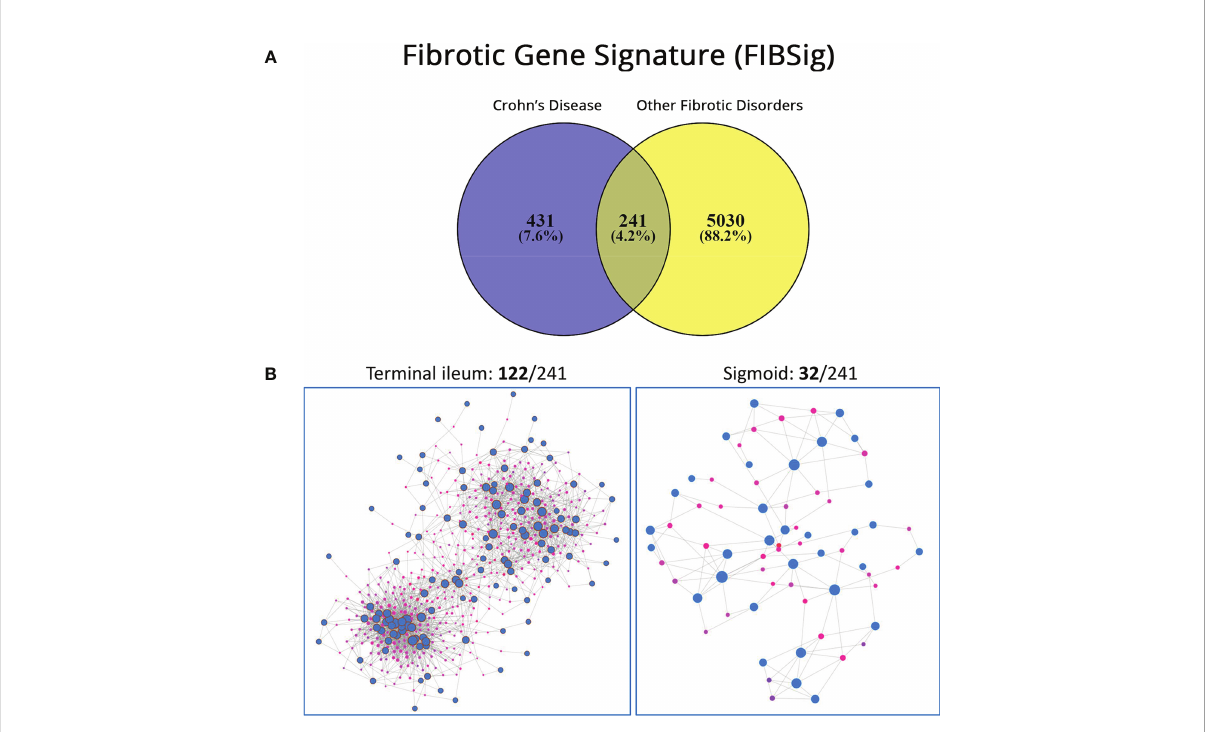
FIGURE 2 (A) Venn diagram reporting on genes expressed in Crohn ’ s Disease, in other fi brotic diseases and their intersection (FIBSig). (B) Tissue-speci fi c expression with the NetworkAnalyst online platform and information form the iNetModels database; signi fi cantly more FIBSig genes were co- expressed in the terminal ileum versus the